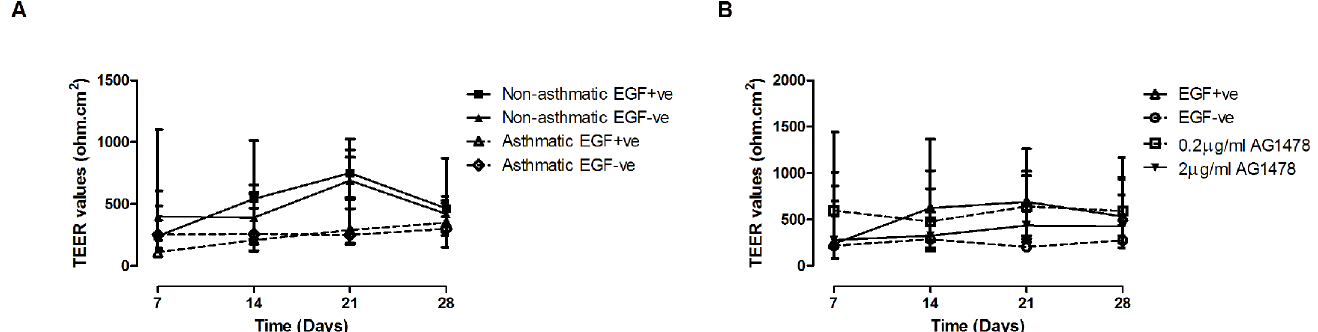
Fig 1. Measurement of Epithelial Resistance. Transepithelial Electrical Resistance (TEER) measurements on days 7, 14, 21 & 28 of ALI culture. (A) TEER measurements over 28 days at ALI for asthmatic and non-asthmatic cultures in the presence or absence of EGF (10ng/ml) (n = 5) and (B) in the presence or absence of EGF +/- AG1478 (0.2 or 2 μ g/ml) (n = 5). Values are expressed as median with interquartile range. Data was analysed using a Kruskal-Wallis test with Dunn ’ s multiple comparison post hoc